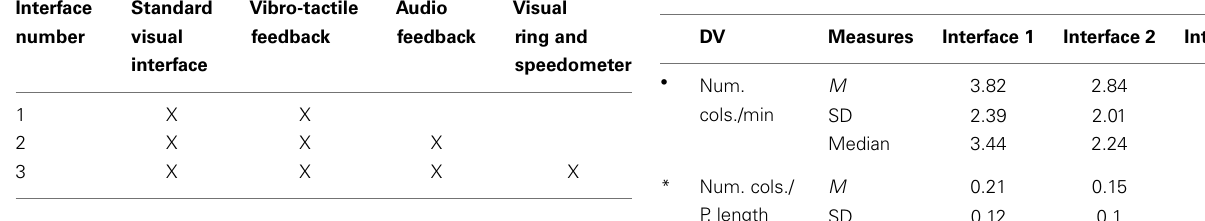
Table 3 | Display features for interface treatments in study #3 . Table 4 | Non-subject-normalized DV results for different interface treatments in study #3